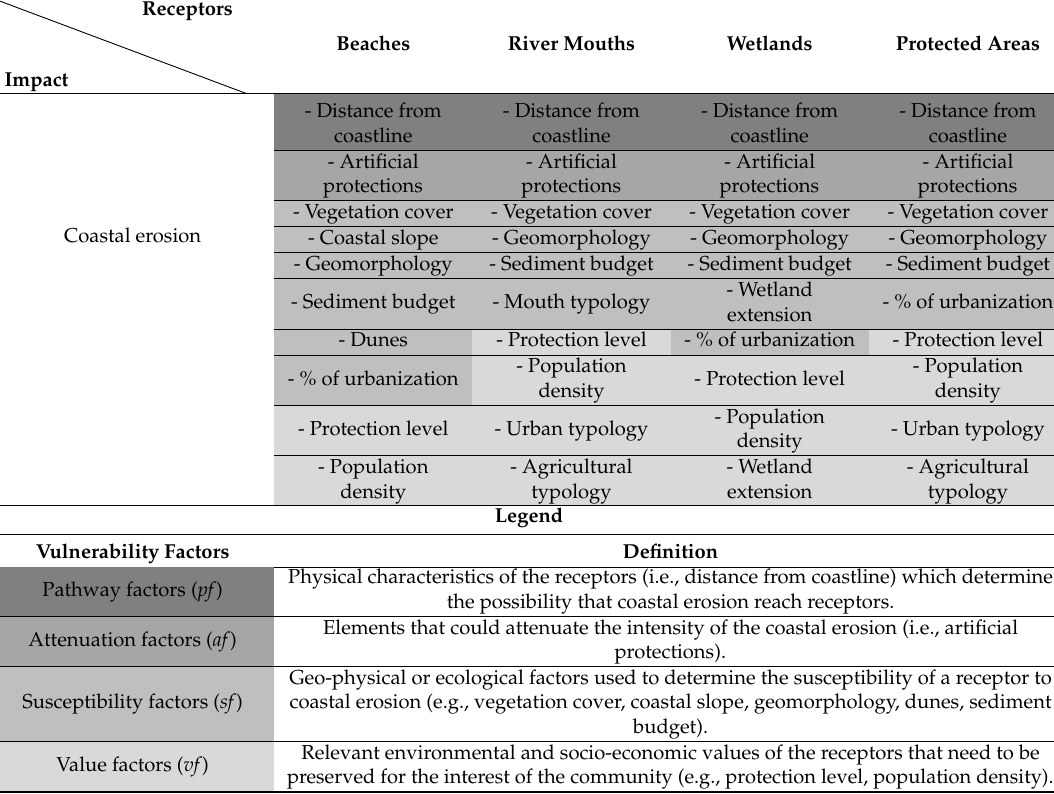
Table 2. Vulnerability matrix showing coastal receptors and vulnerability factors applied for the Regional Risk Assessment of coastal erosion in the North Adriatic coast.